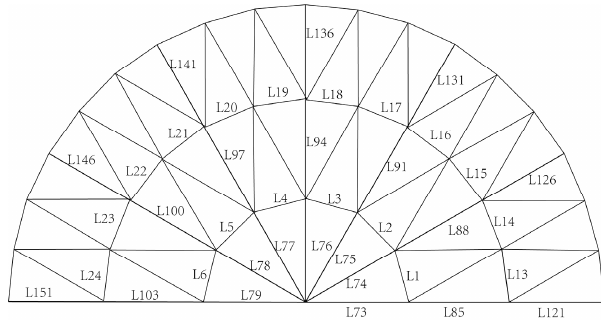
Figure 4. Schematic diagram of member numbering.